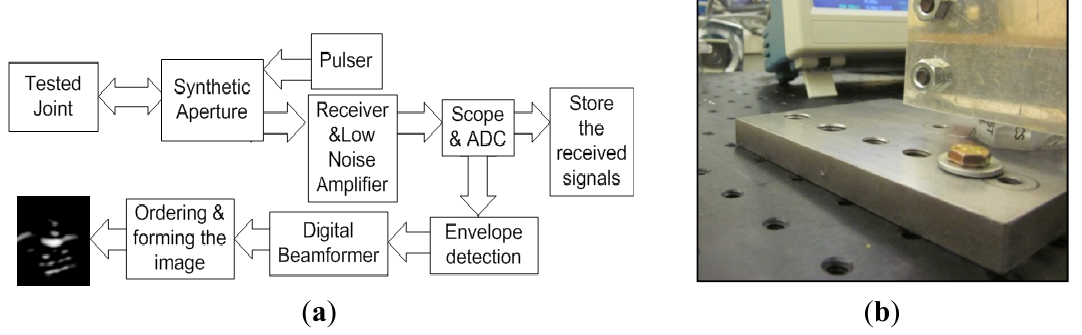
Figure 4. ( a ) The block diagram and ( b ) the photographic illustration of the experimental